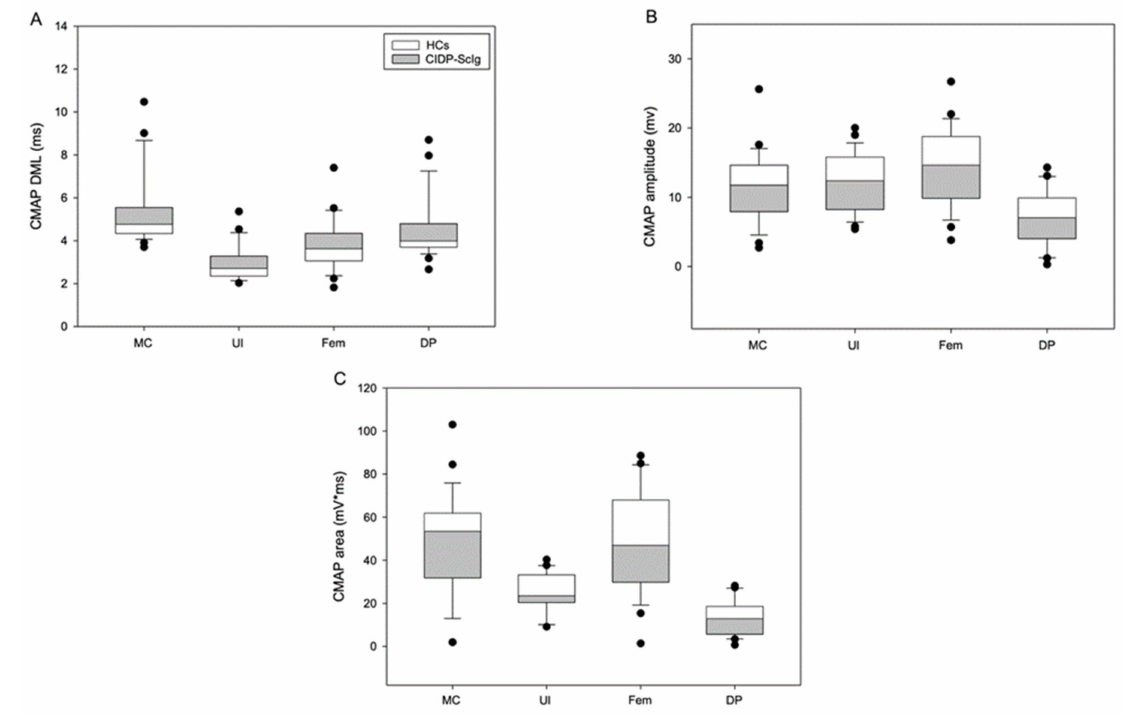
Figure 2. ( A – C ) Analysis of nerve conduction parameters (DML and CMAP amplitude and area) in CIDP patients after ScIg treatment and HCs (CIDP patients vs. HCs). Figure legend: HCs: healthy controls; CIDP: chronic inflammatory demyelinating polyneuropathy; ScIg: subcutaneous immunoglobulin; MC: right musculocutaneous; Ul: left ulnar; Fem: left femoral; DP: right deep fibular; DML: distal motor latency; CMAP: compound muscle action potential.